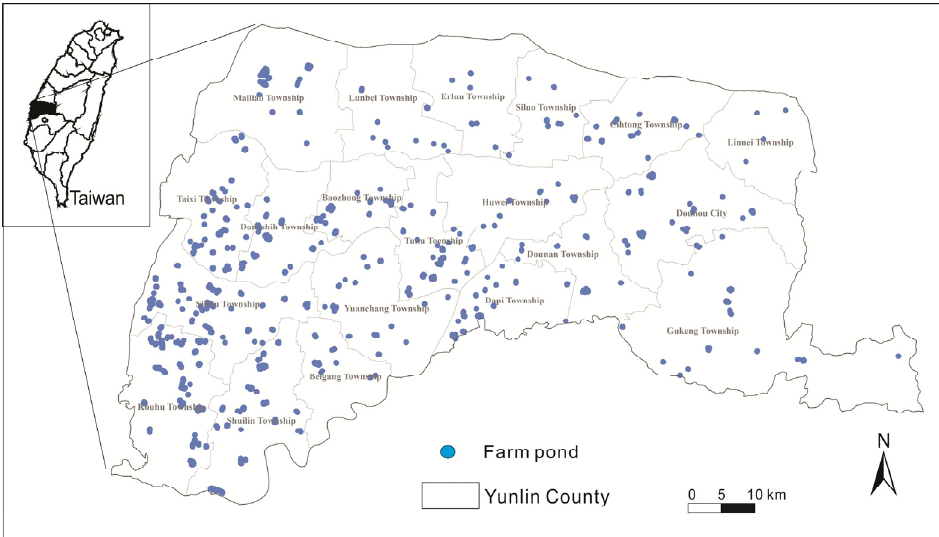
Figure 1. Research areas and location of farm